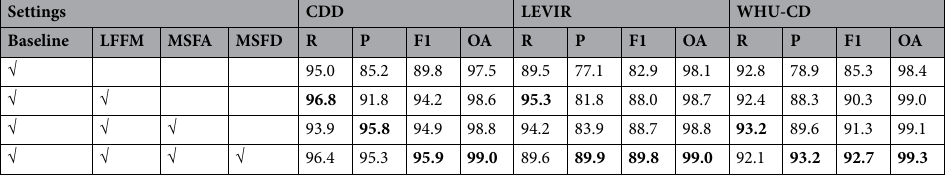
above, and can also extract the key region features and obtain an enhanced feature representation, making the network robust. It can be seen from the three datasets that, compared with Baseline + LFFM, although the model